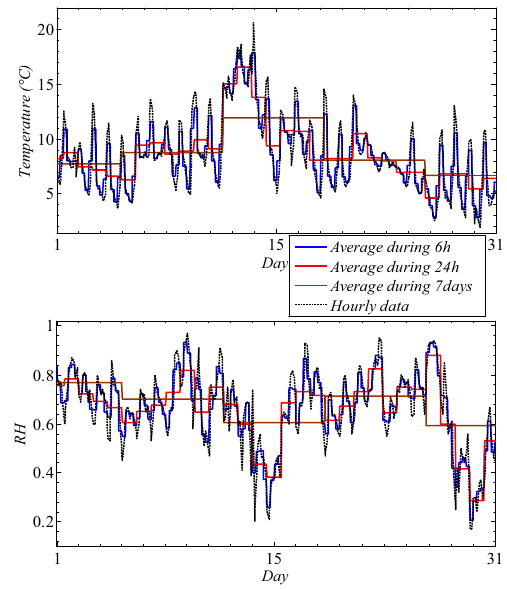
Fig. 11 Environmental data averaged during various time- steps for a month, in Nice,